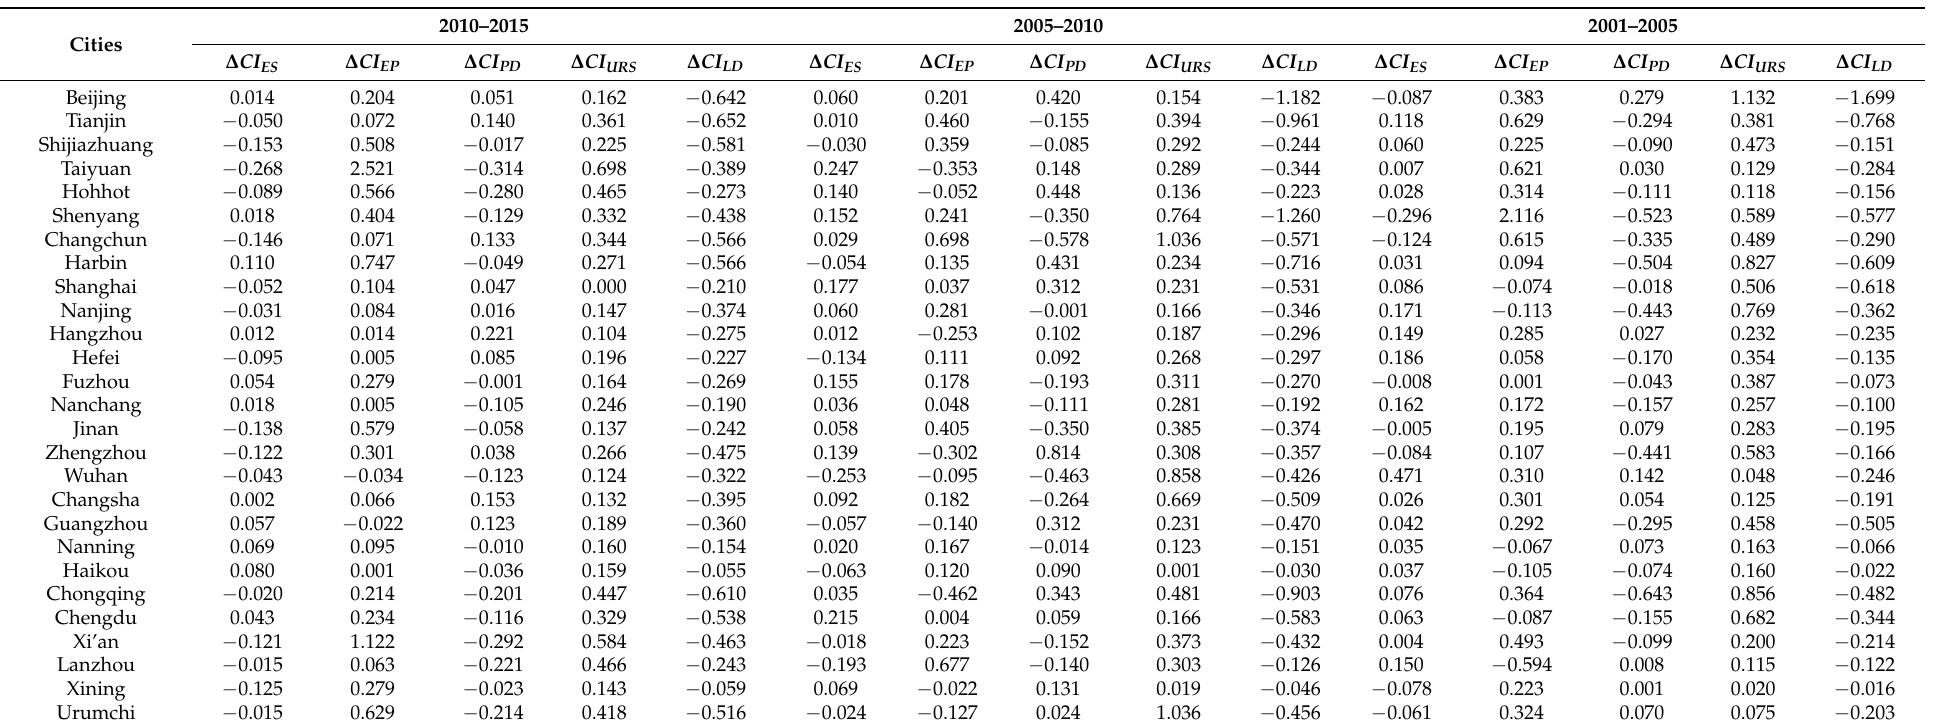
Table 6. Results of the decomposition analysis for capital cities (tCO 2 /(10 4